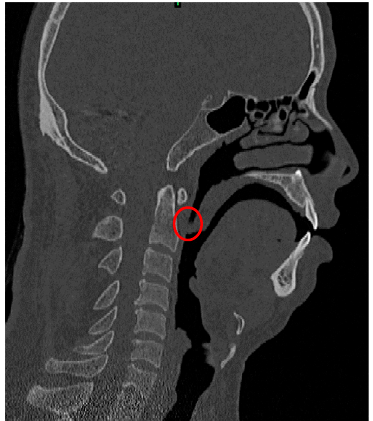
Figure 1. Sagittal plane CT image of OSAHS patient.